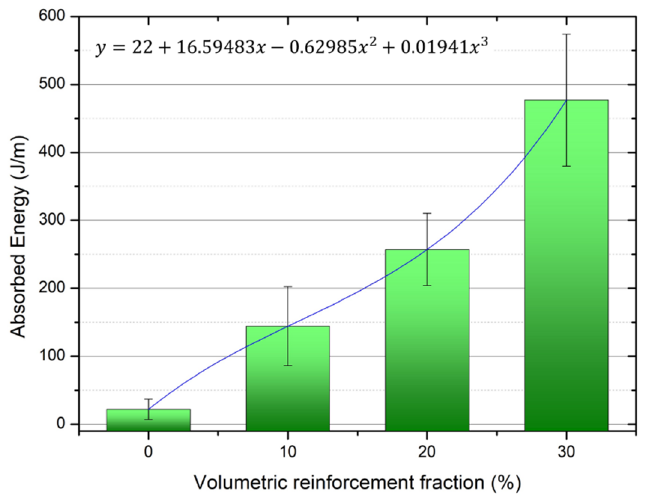
Figure 3. Variation of Izod absorbed impact energy with the volume fraction of guaruman fiber in the epoxy matrix composites. Neat epoxy value obtained from [26].